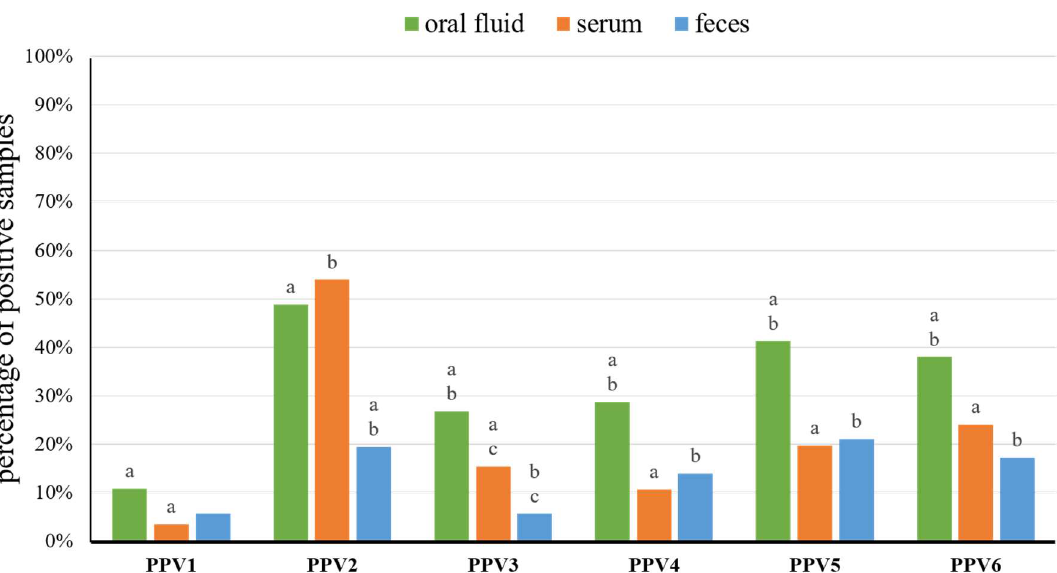
Figure 1. Percentage of porcine parvoviruses 1–6 (PPV1–PPV6) positive samples of oral fluid ( n = 150), serum ( n = 254), and feces ( n = 252). Statistically significant differences ( p < 0.05, Fisher’s exact test) between diagnostic materials, within grouped bars for each virus, are marked with superscripts on the top of bars in the chart (a, b, and c).